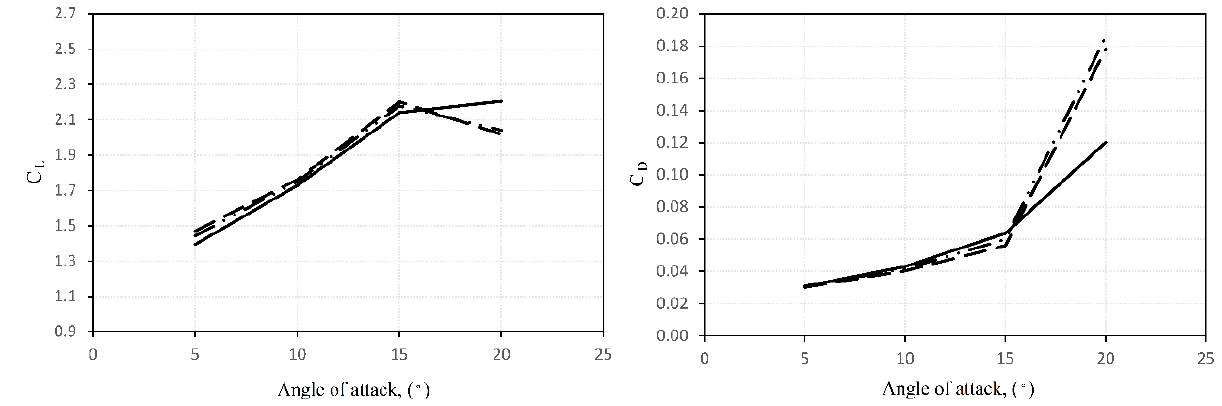
Figure 8. Lift and drag coefficients of the airfoil equipped with VGs in the presence of Gurney flap with H / c =2% for the